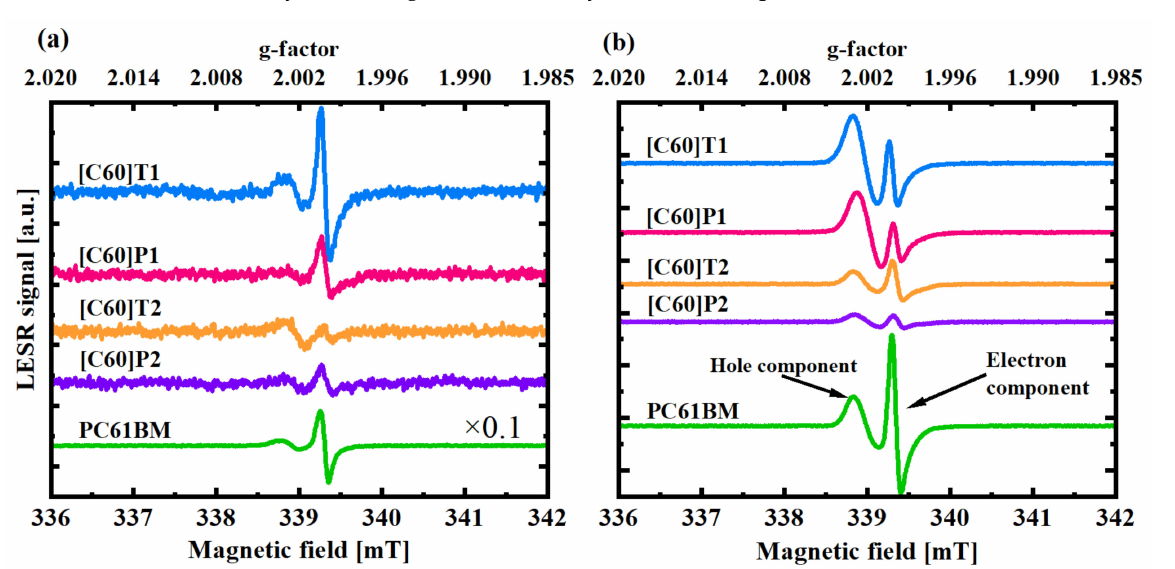
Figure 5. LESR signal at 30 K and for 0.00474 mW of microwave power of ( a ) differently functionalized fullerene derivatives; note that the reference signal of the PC61BM fullerene was divided by 10 due to its high intensity, ( b ) fullerene derivative blends with P3HT. The signals are vertically shifted for better clarity with the scale